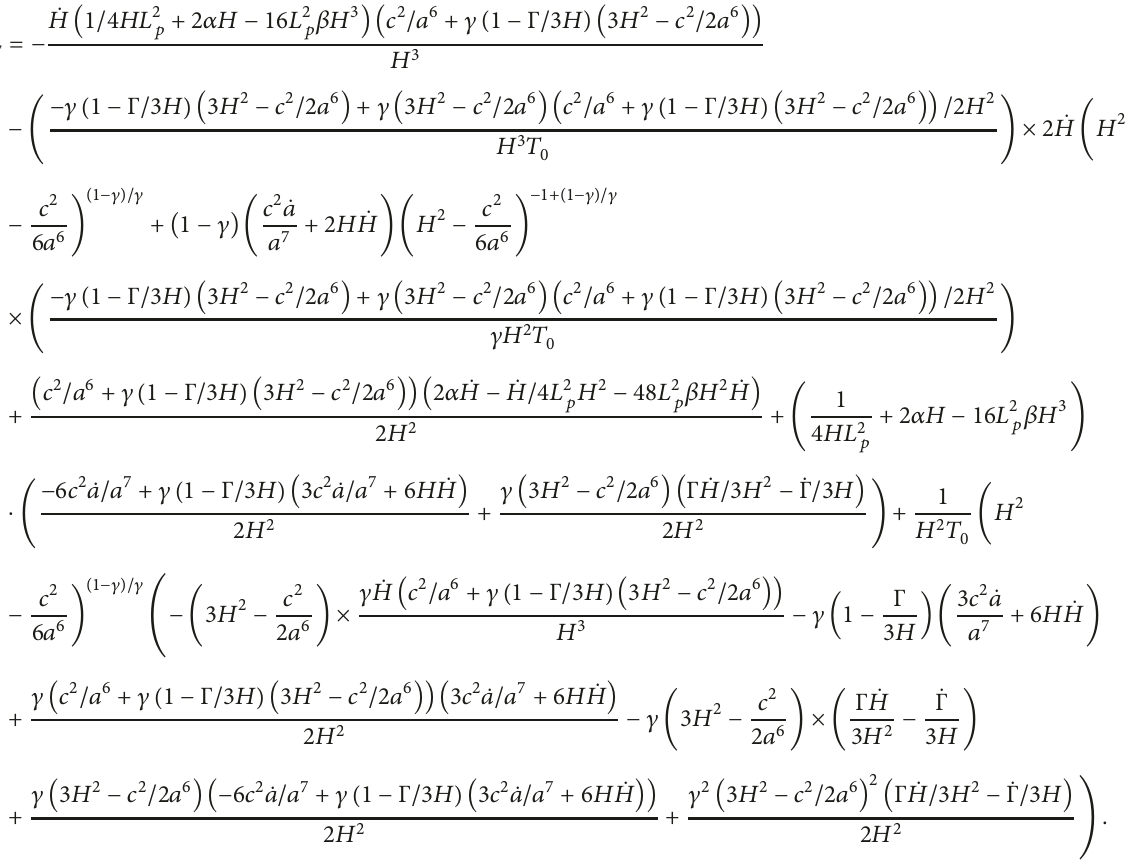
Logarithmic Corrected Entropy . We discuss the stability anal- ysis of thermal equilibrium in the presence of logarithmic corrected entropy by taking Γ as variable for which (36) reduces to second-order differential equation